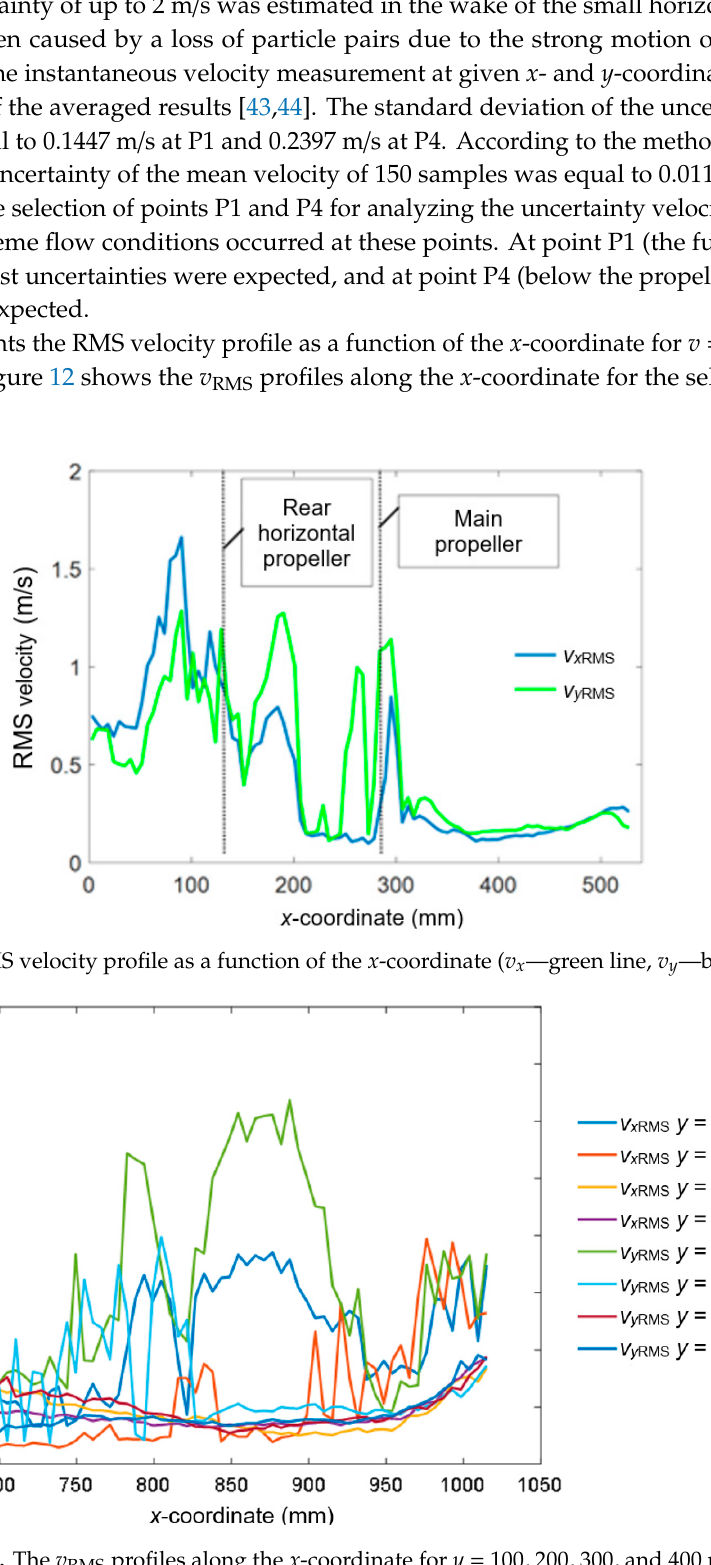
Figure 12. The v RMS profiles along the x -coordinate for y = 100, 200, 300, and 400 mm.